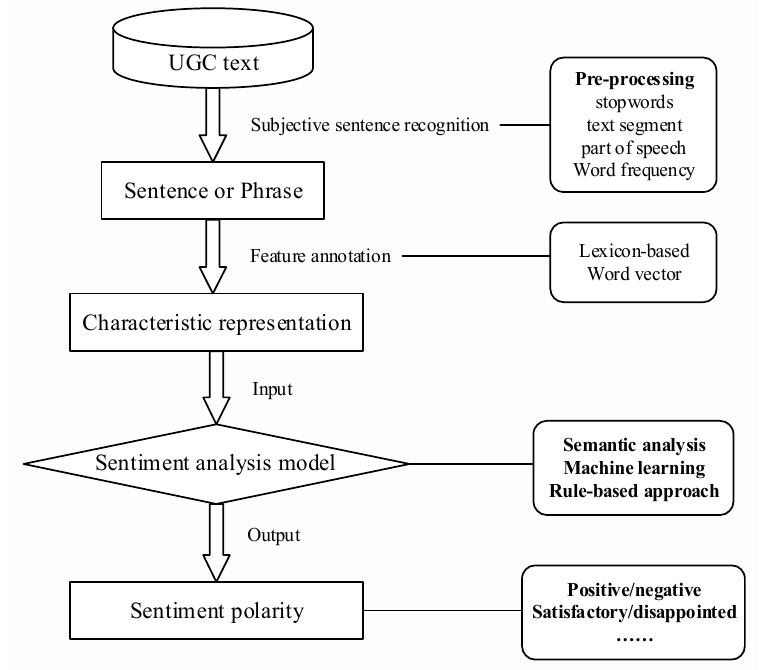
Figure 3. Sentiment analysis process of UGC.